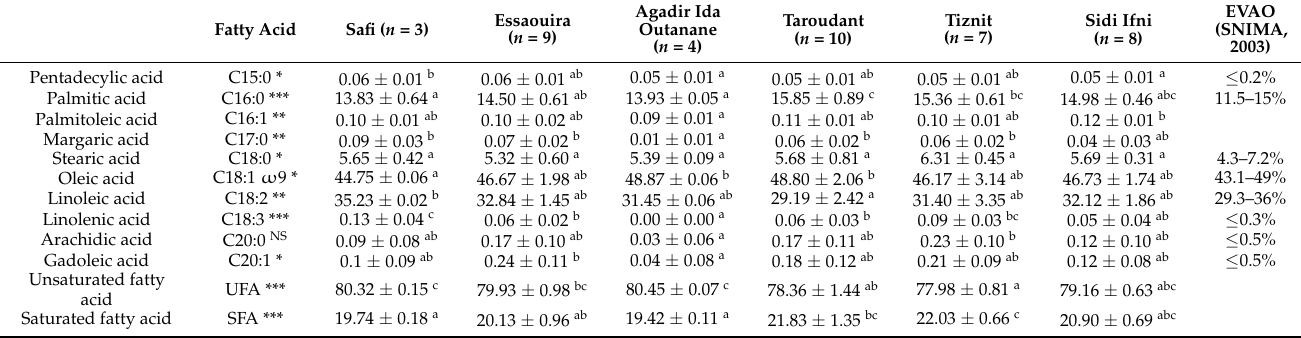
Table 1. Fatty acid composition of Argan oils from different geographical